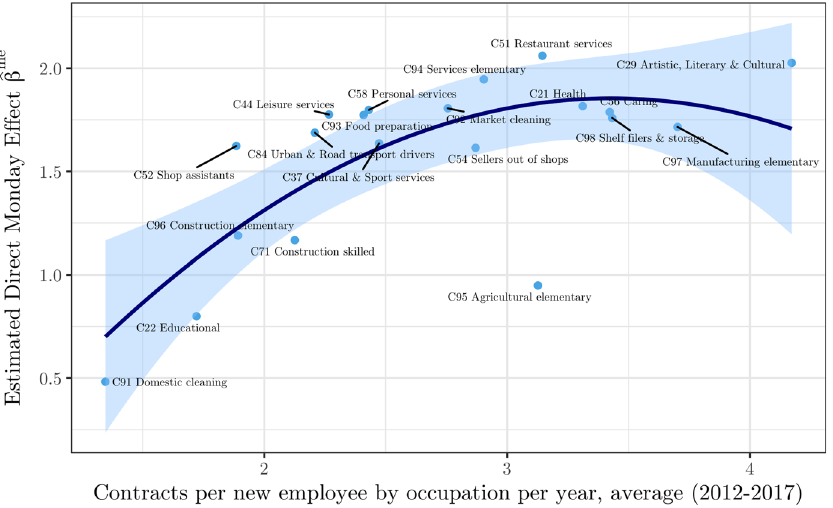
Fig. 9 Average contracts per new employee and the direct monday effect by occupation, 2012–2017. All β ’s from selected occupations